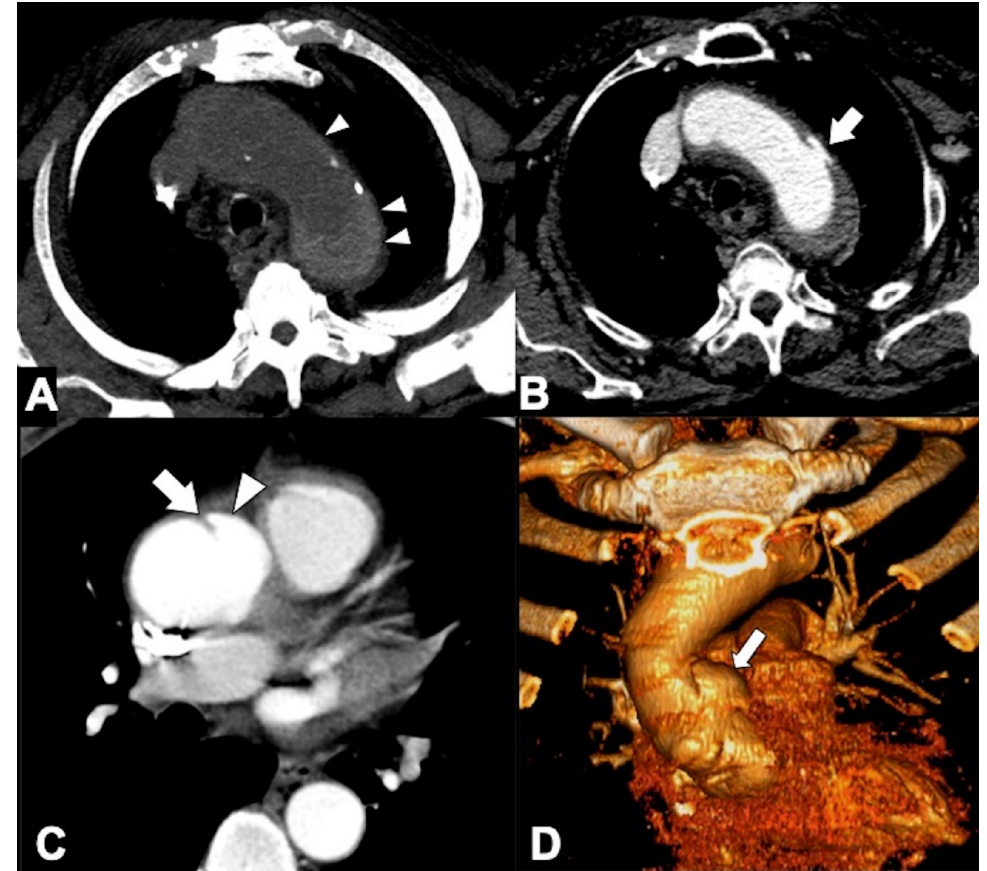
Figure 10. CTA features of Svensson’s Class 4 (PAU) and Class 3 (limited intimal tear) variants. ( A ) Axial unenhanced CT image shows aortic arch high-density intramural hematoma (IMH) in a 74-year-old male with acute neck and chest pain (arrowheads). ( B ) CTA axial scan in the same patient shows a flat penetrating ulcer (arrow) with associated IMH in the arch convexity. ( C ) CTA axial image shows a linear filling defect with subtle undermined edges (arrow) and eccentric medial one-sided bulge of the ascending aorta (arrowhead) without a clear intimomeadial flap or false lumen in a 58-year-old male with sudden onset of chest and back pain. ( D ) 3D-VR oblique coronal reconstruction confirms the eccentric one-sided saccular aortic bulging (‘‘mushroom cap’’ morphology) of class 3 dissection (arrow).